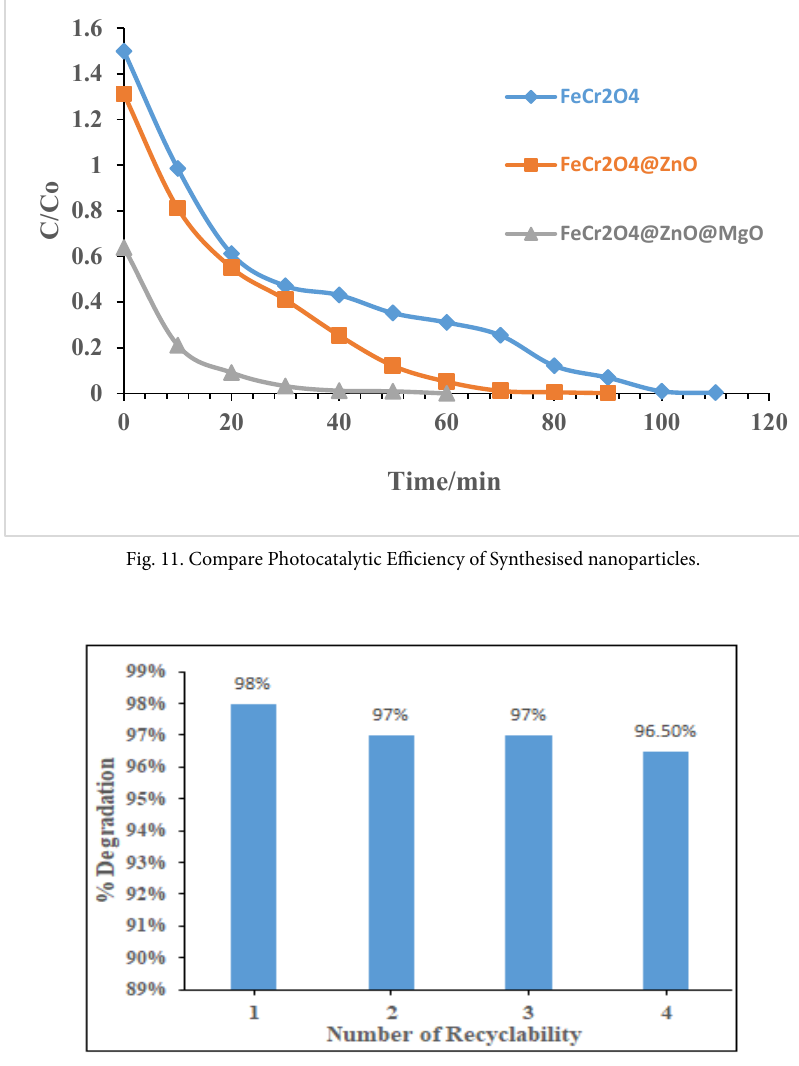
O @ZnO@MgO Core-Shell nanoparticles for degradation of Orange G 2 4